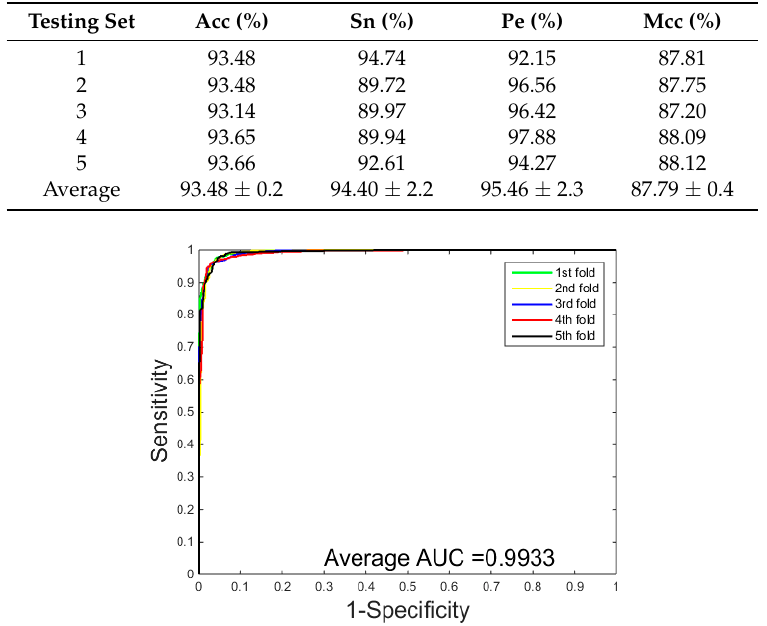
Figure 2. ROC curves performed of a probabilistic classification vector machines model (PCVM) on the Yeast dataset.